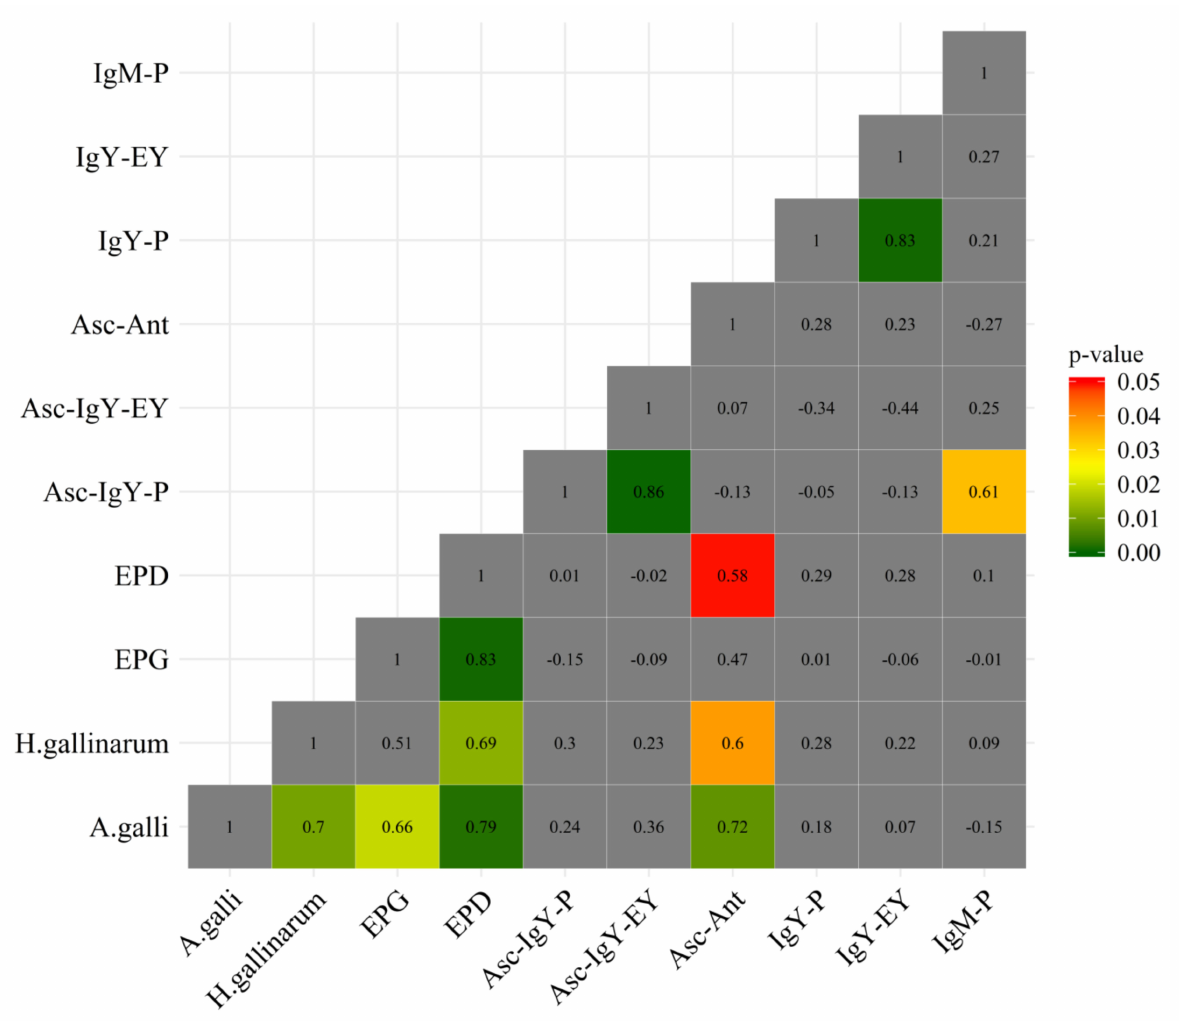
Figure 1. Heatmap of associations between phenotypic traits included in the study. Values shown in the boxes are Pearson’s correlation coefficients. Non-grey-coloured boxes indicate significant